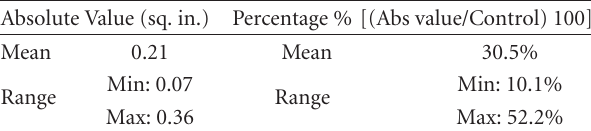
Table 2: Freehand